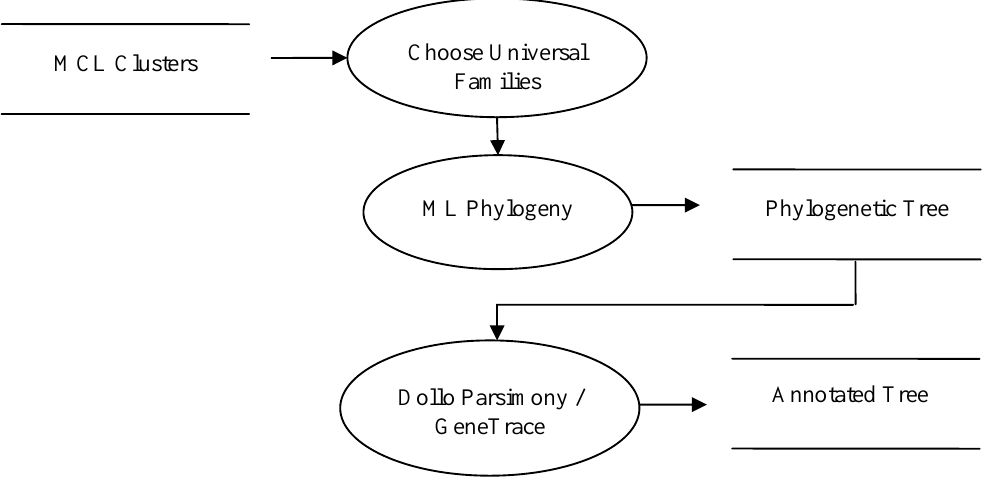
Figure 2: A data flow diagram for phylogenetic